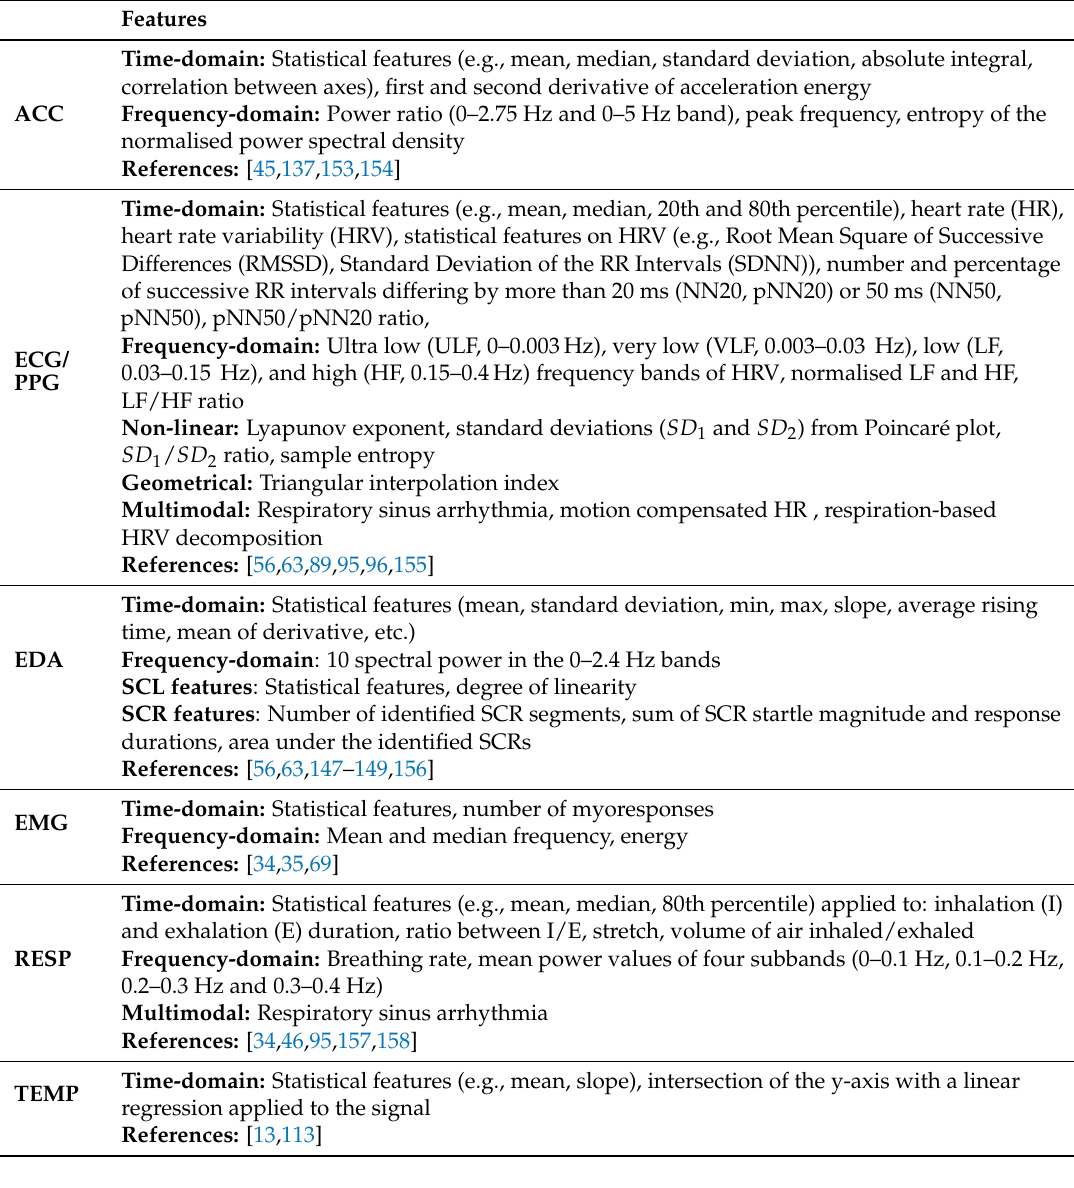
Table 8. Features commonly extracted and applied in the wearable-based